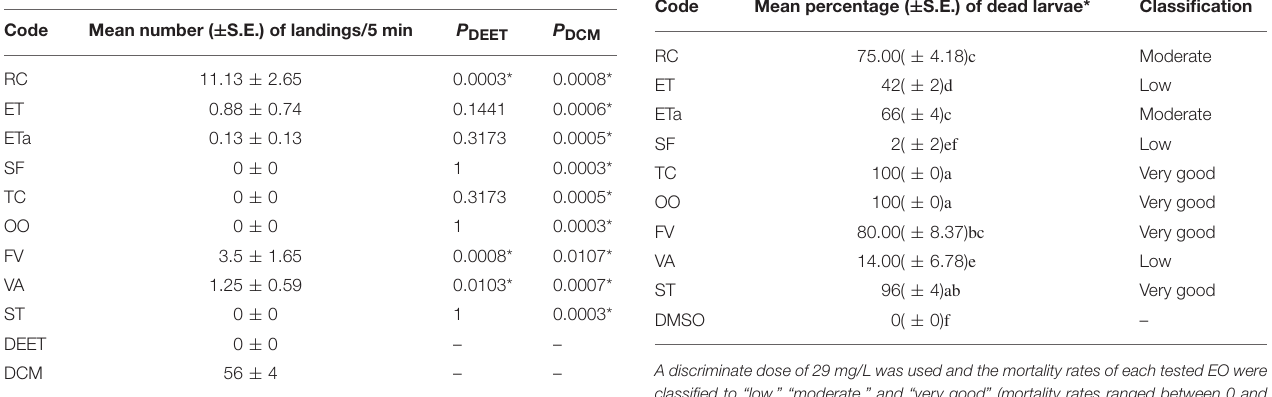
TABLE 3 | Mean number ( ± S.E.) of Aedes albopictus landings on the uncovered area of the glove in 5min and comparison with the standard DEET and the control (dichloromethane, DCM) after using different essential